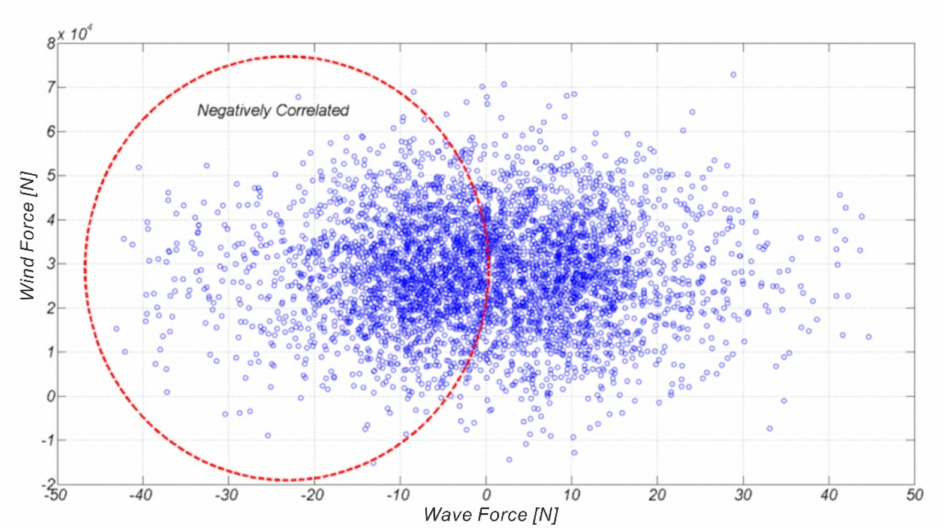
Figure 21. Trajectories of the wave force and wind force.